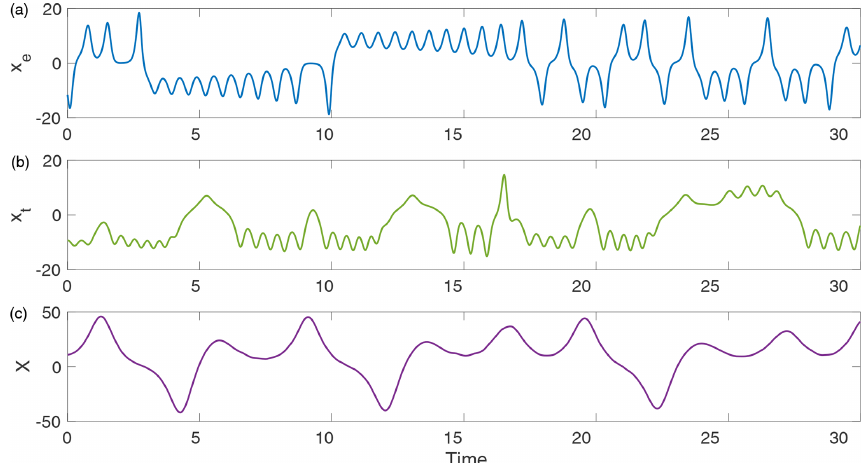
Figure 1. Example trajectories of the coupled Lorenz model (Eq. 1) for x e (a) , x t (b) , and X (c) .